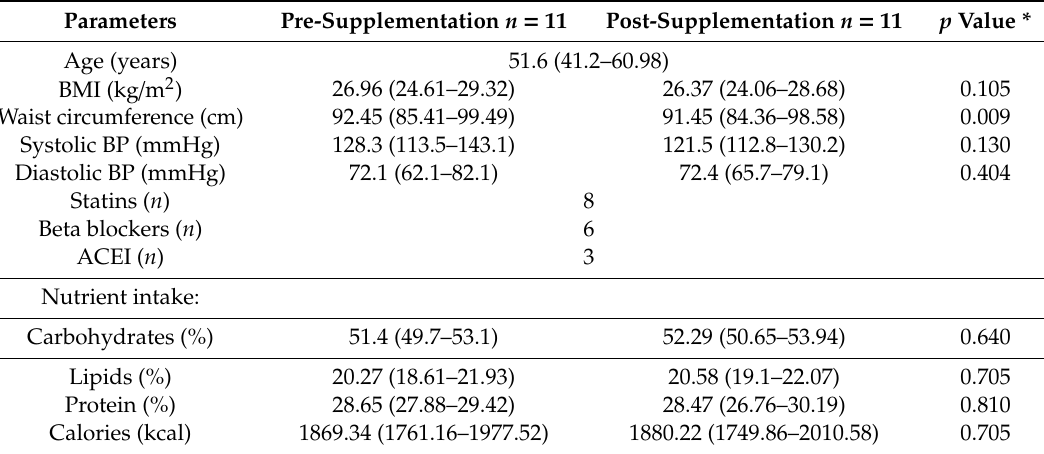
Table 1. Anthropometric characteristics of the included acute coronary syndrome (ACS) patients and nutrients intake before and after the supplementation with microencapsulated pomegranate